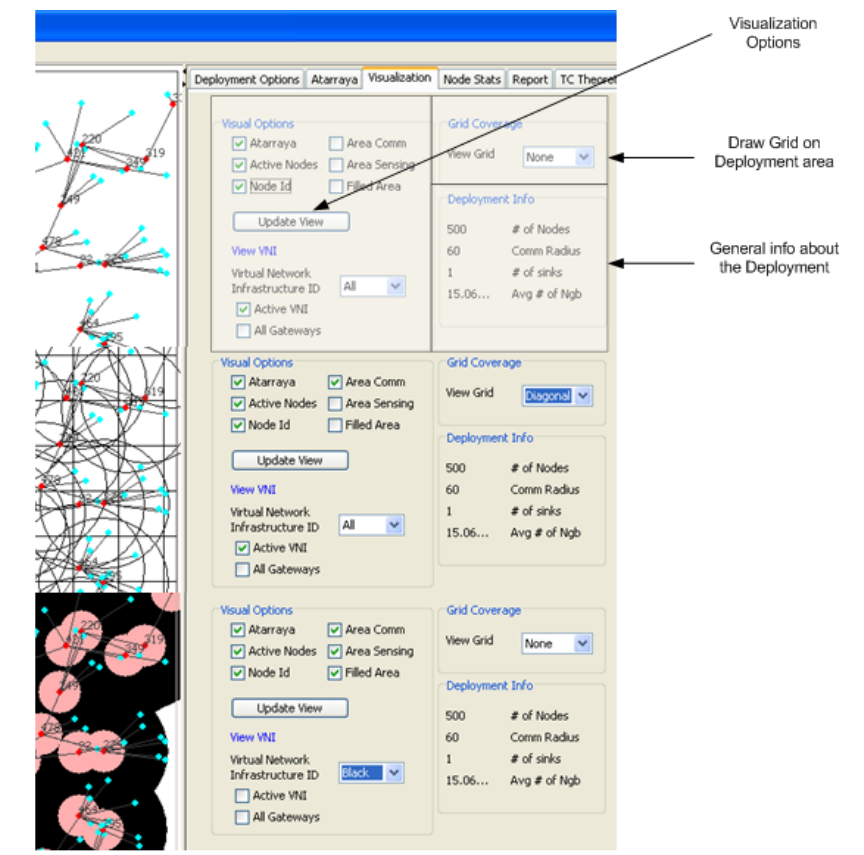
Figure 5. A sample of the Attarraya visualization